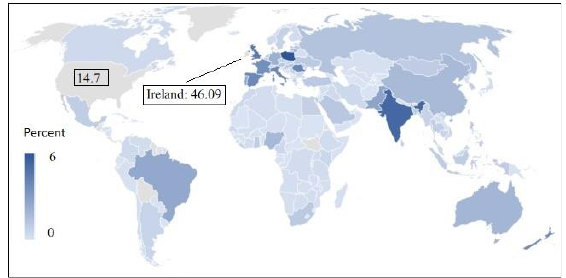
Figure 2: Nationality of Google POI Reviewers Figure 2 is a map of reviewers' backgrounds, excluding Irish and American. Because of the high number of reviewers from Ireland and the US, we excluded them from our spatial analysis to better visualize the potential origin countries of other reviewers. This map shows that most reviewers have a active on the Google Map